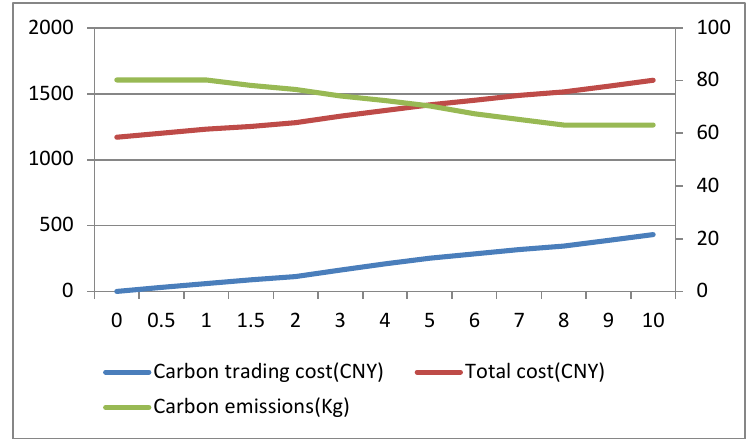
Figure 4. The changing trends of carbon emissions and total cost with the carbon price changes under insufficient carbon quota.